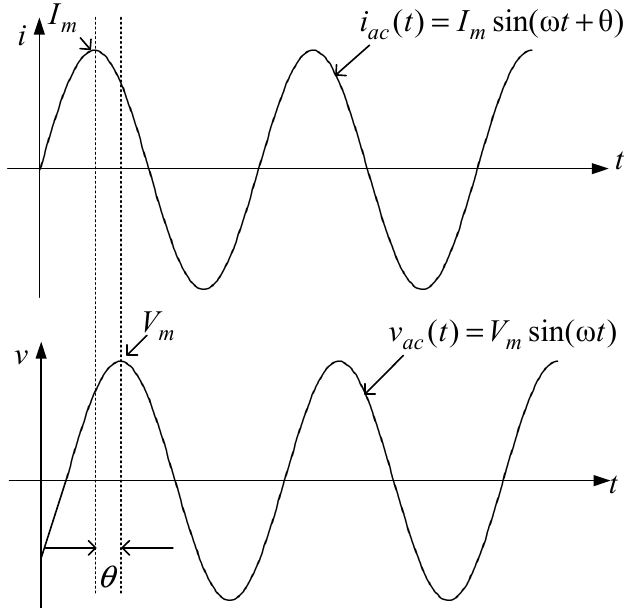
Figure 8. The charge current and battery voltage waveforms with DC components